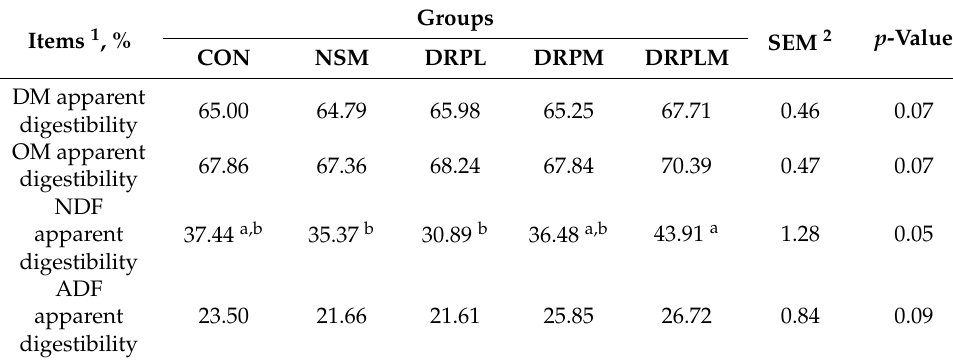
Table 4. Effects of dietary supplementation with rumen-protective amino acids on nutrient apparent digestibility of Hu sheep.